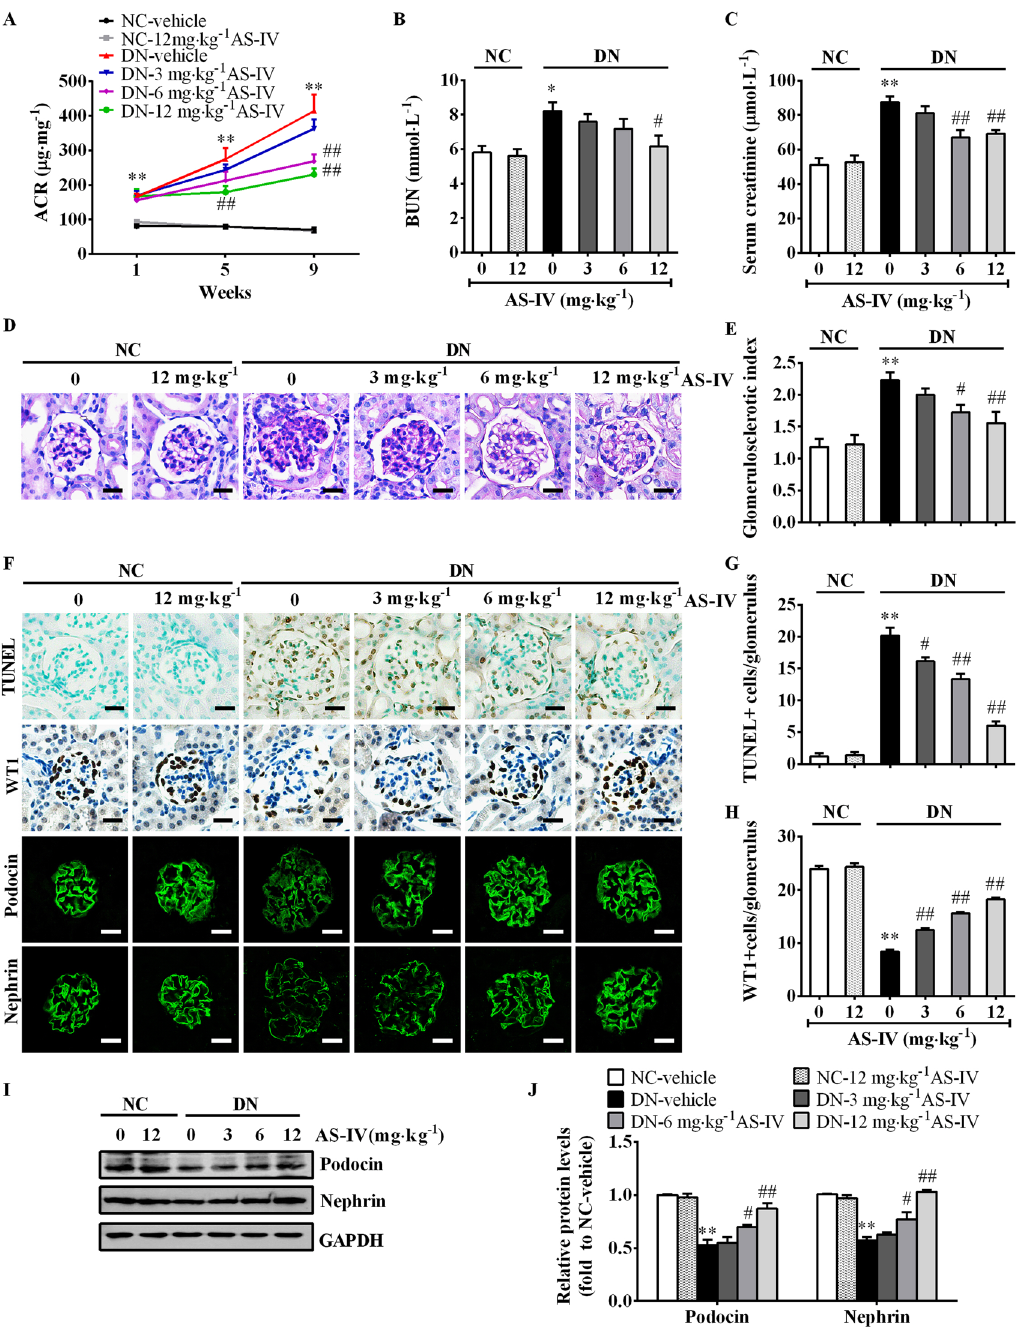
Figure 1. AS-IV prevented the progression of DN in STZ-induced diabetic mice. 8-week-old C57BL/6J mice were injected intraperitoneally with 100 mg·kg − 1 STZ for 2 consecutive days in the first week (week 0). 1 week after STZ injection (week 1), the mice were treated with AS-IV at the indicated doses for 8 consecutive weeks. Urinary albumin to creatinine ratio (ACR) was measured at 4-week intervals ( A ). Serum BUN ( B ) and serum creatinine ( C ) were detected at the end of the study. ( D ) PAS staining. Scale bars, 10 μ m. ( E ) Glomerulosclerotic index based on PAS staining. ( F ) Representative images of TUNEL staining, immunohistochemistry staining for WT-1 and immunofluorescence staining for Podocin and Nephrin. Scale bars, 10 μ m. ( G ) Quantification of TUNEL-positive cells in each group. Data was expressed as TUNEL-positive cell number per glomerulus. ( H ) Quantification of podocyte number in each group. Results were represented as WT-1-positive podocyte number per glomerulus. ( I , J ) Representative immunoblots ( I ) and densitometric quantification ( J ) of Podocin and Nephrin expression in total lysates of kidney cortex from each group. The original blots for panel I were presented in Supplementary Figure S2. Data are expressed as mean ± SEM. n = 10–12 for A–C and n = 4–6 for D–J. ** P < 0.01 compared to NC-vehicle group; # P < 0.05, ## P < 0.01 compared to DN-vehicle group. One-way ANOVA and Newman-Keuls multiple comparisons test ( A – C , E , G , H , J ). NC, non-diabetic control. DN, diabetic